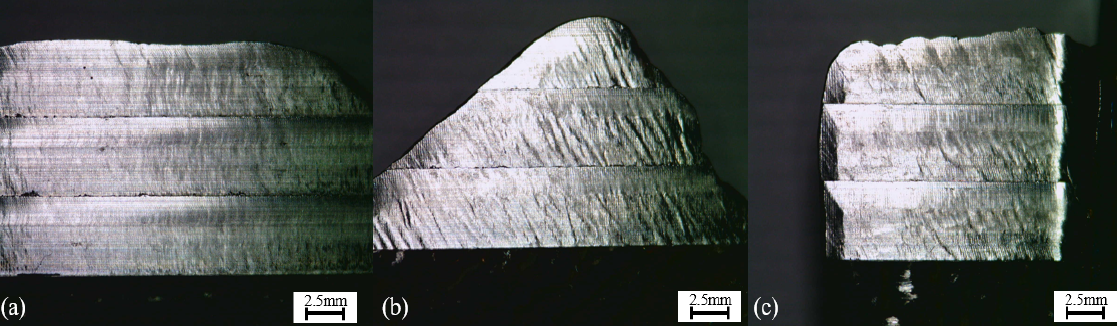
Figure 5. Machined Surfaces—( a ) 0 degrees sample, ( b ) 35 degrees sample, ( c ) 90 degrees sample . Different aspects of the samples could be observed with the aid of the